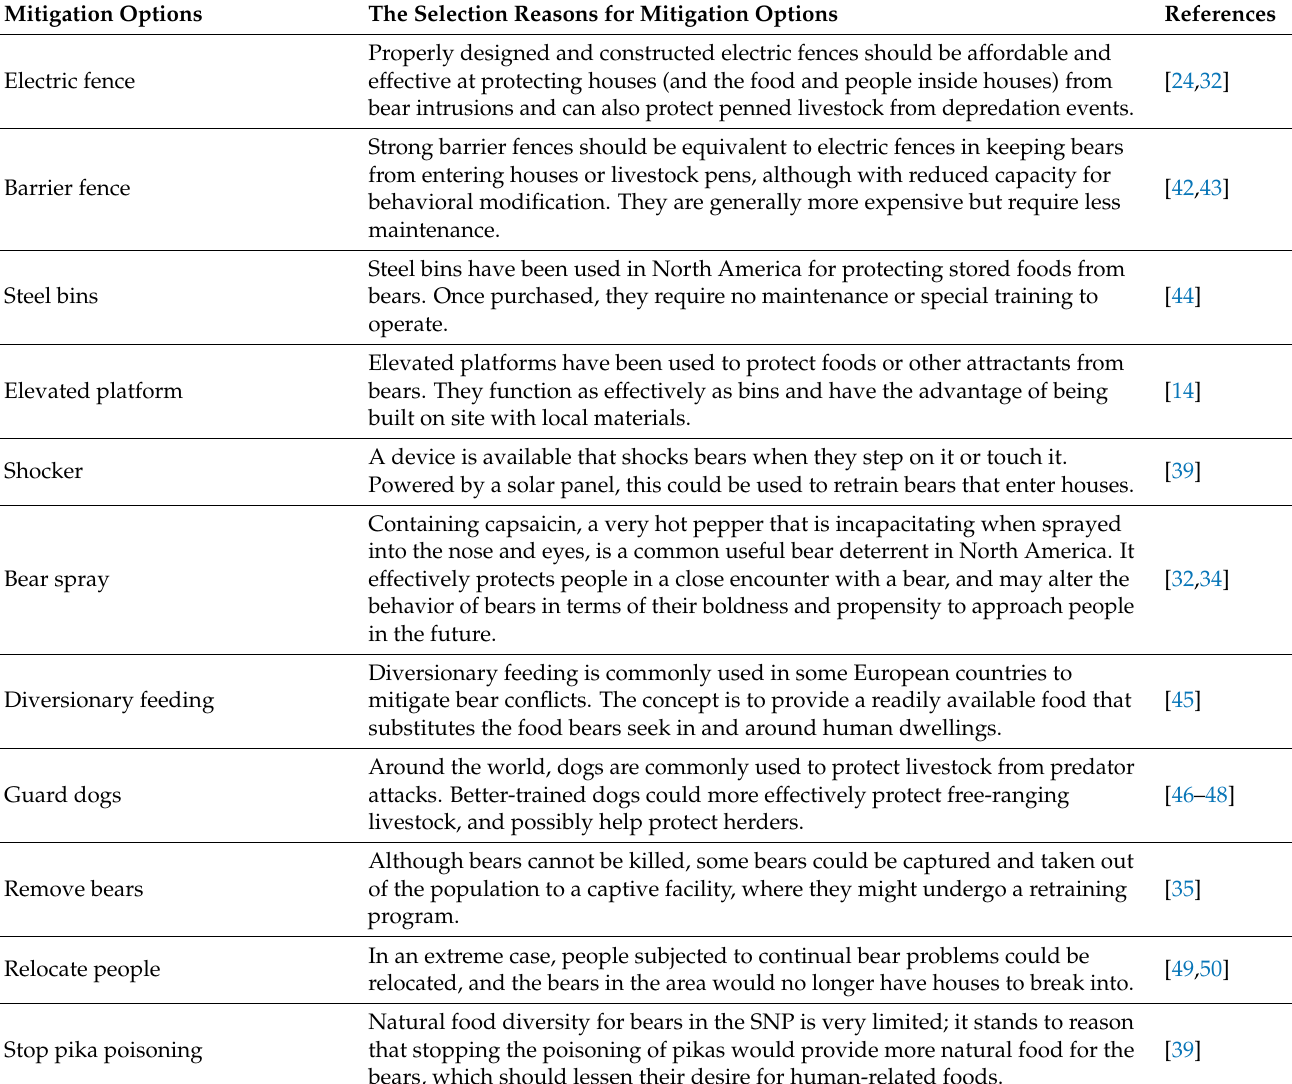
Table 1. The potential HBC mitigation options for the Sanjiangyuan Region based on the field survey and practical experience of measures in other